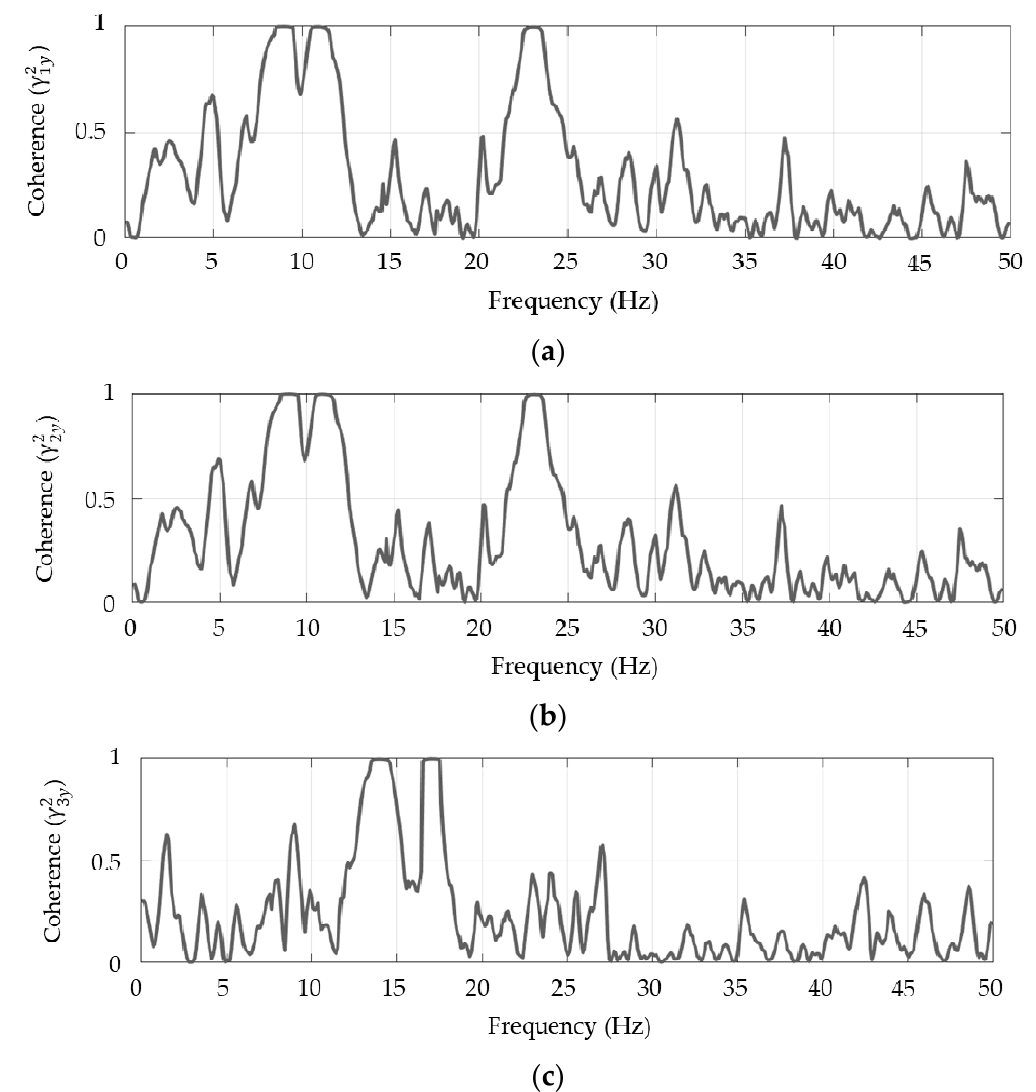
Figure 5. Ordinary coherence between input and output: ( a ) γ 2 1 y , ( b ) γ 2 2 y , ( c ) γ 2 3 y